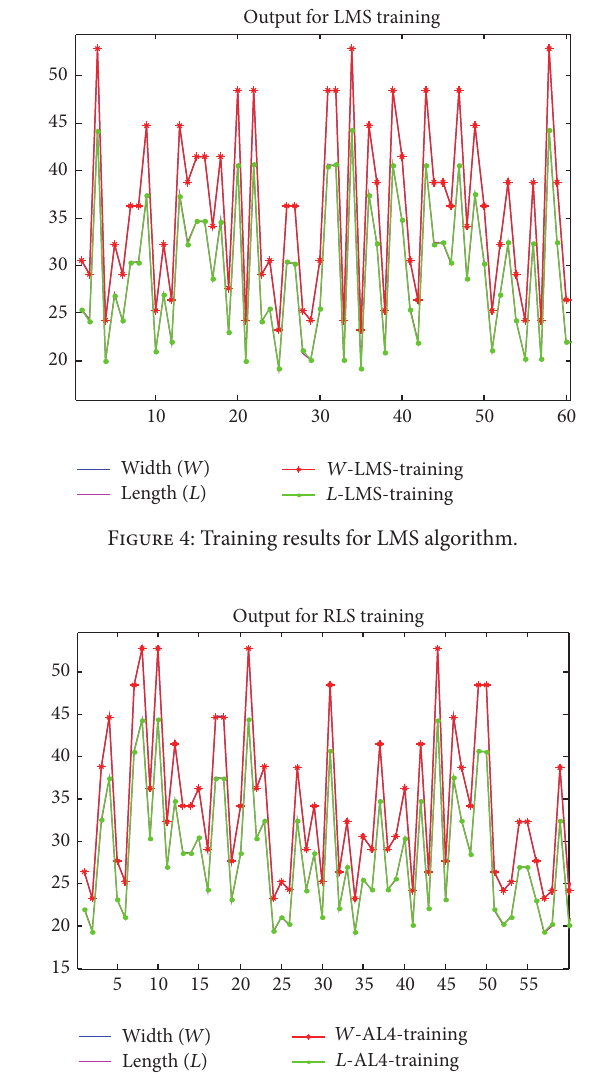
Figure 5: Training results for RLS algorithm with the adaptive spread.